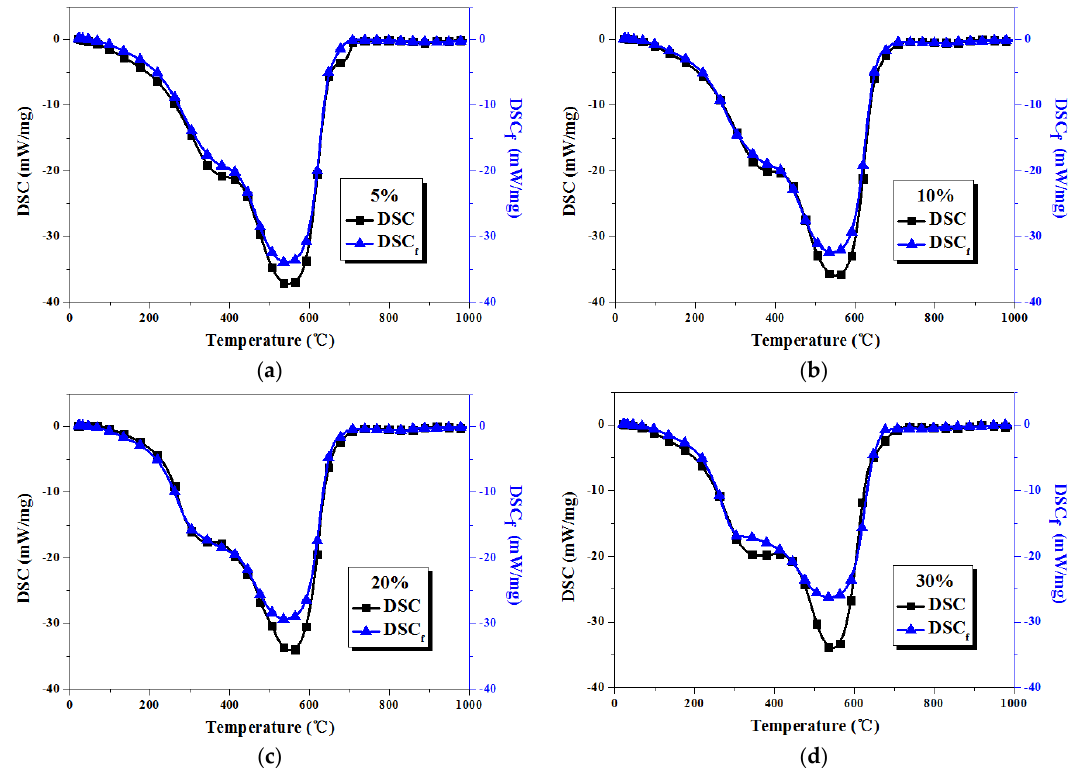
Figure 7. Actual and fitted DSC curves for coal-sludge (S 1 ) blends of different dried sludge weight percentages (heating rate = 30 °C/min) (( a ) 5%; ( b ) 10%; ( c ) 20%; ( d ) 30%).